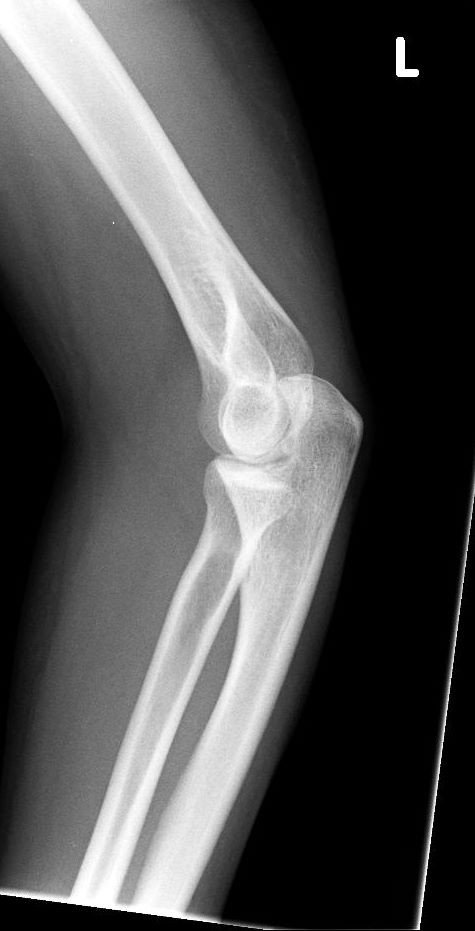
Lateral xray Elbow.